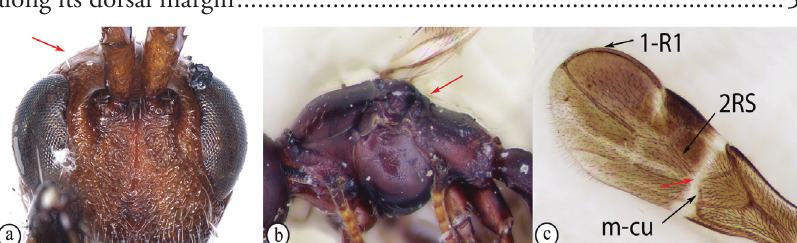
– Frons and vertex without raised protuberances (a). Antenna not widened apically. Metanotum without such dorsal lamella (b). Metacarp (1-R1) of fore wing complete (c). Recurrent vein (m-cu) of fore wing postfurcal, arising apicad of first radiomedial vein (2RS) (c). Hind tibia without any spines along its dorsal margin ................................................................................ 5